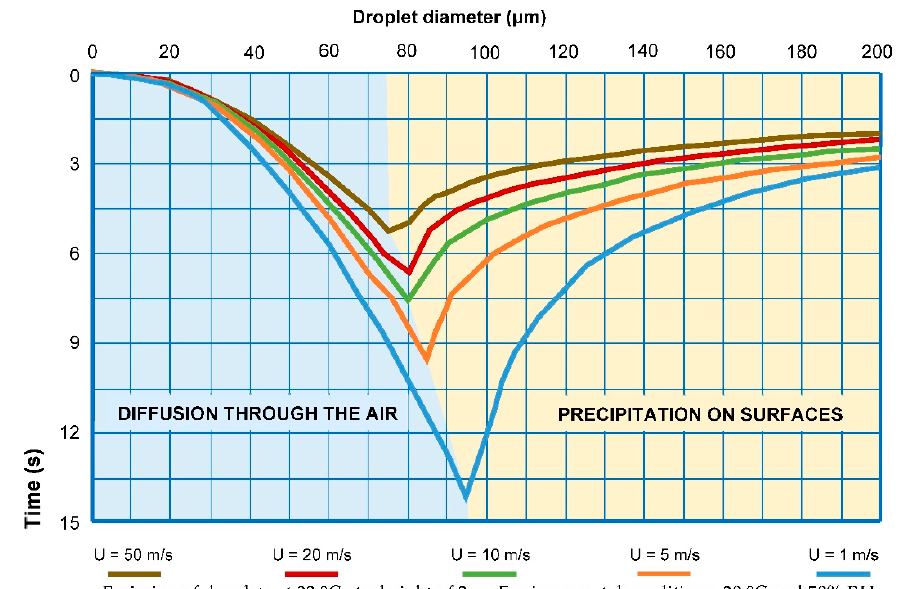
Figure 5. Behaviour of emissions according to their diameter [14].